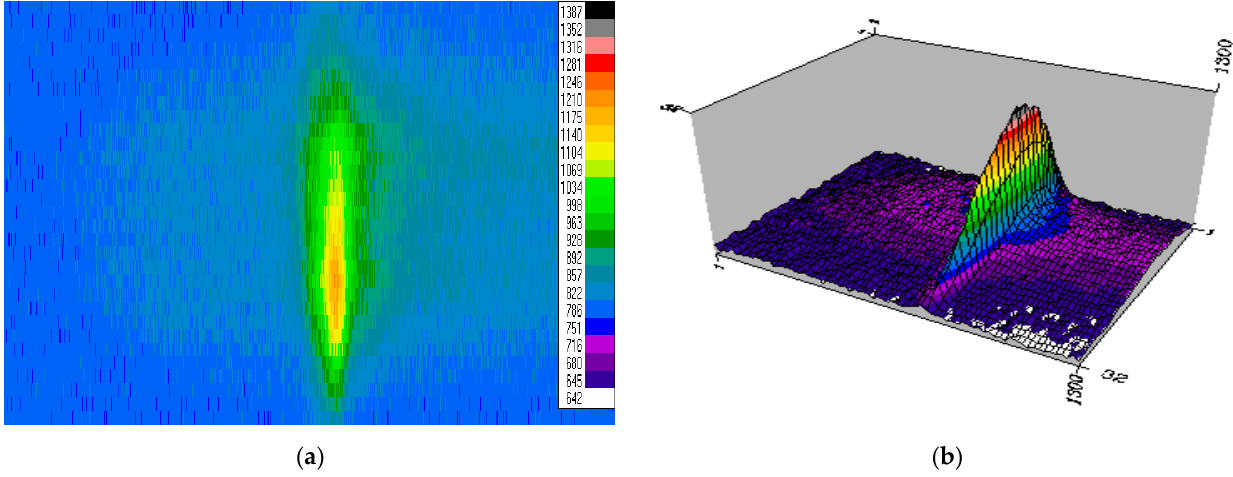
Figure 11. ( a ) Image profile of the spectral line 477.16 nm, and ( b ) three ‐ dimensional emis ‐ Figure 12. ( a ) Image profile of the spectral line 477.16 nm, and ( b ) three-dimensional emission profile. sion profile. Unfortunately, most of the emission lines of the Cd 2+ made up the plasmas lies in the ultraviolet region of the electromagnetic spectrum outside the range of our spectrometer